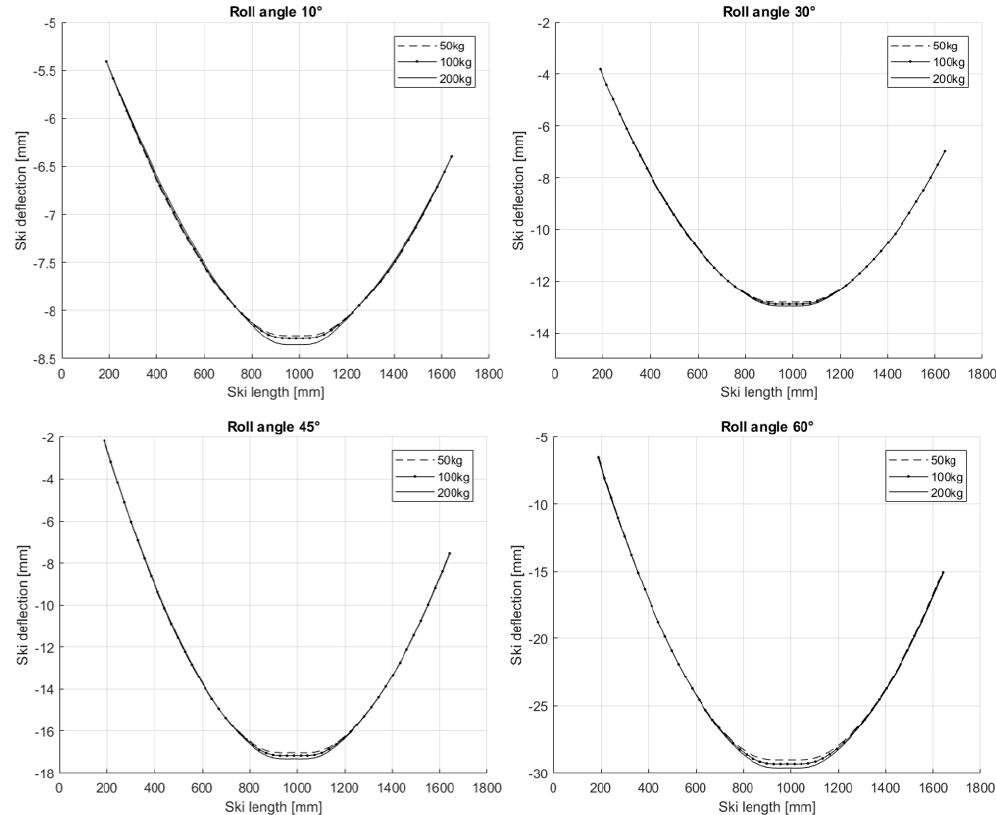
Figure 18. Deflection of the ski for different roll angles and loads.